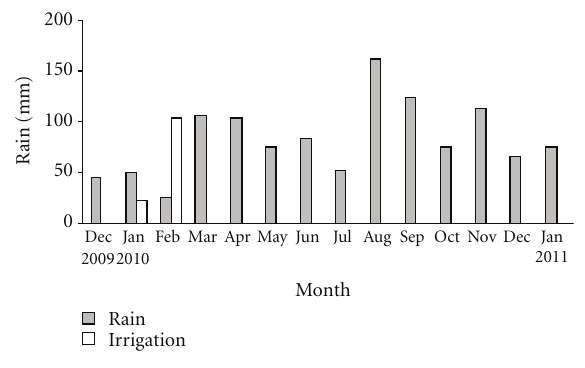
Figure 2: Monthly rainfall and irrigation for the trial period.